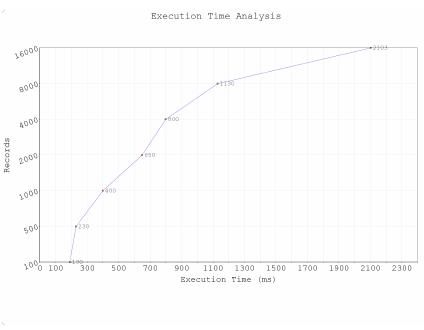
Figure 4. Details of Transformation step of proposed (ETL) approach which is applied to COVID-19 Data (CSV files)